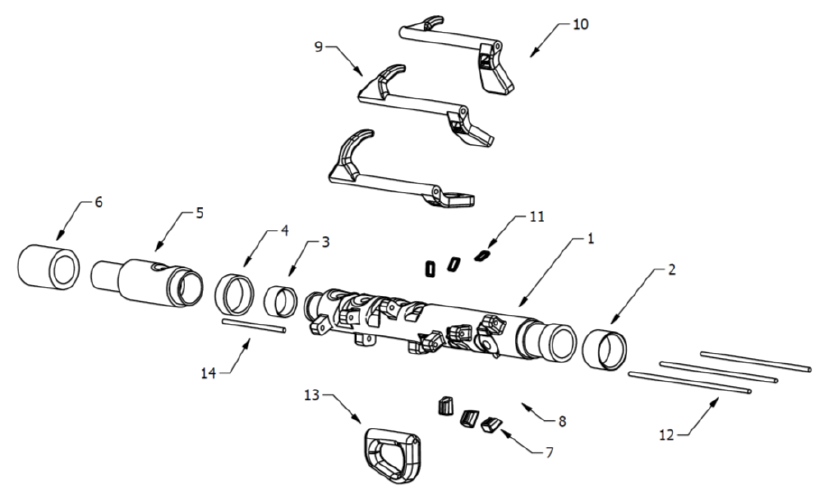
Figure 4. Exploded-view of Flow concept.